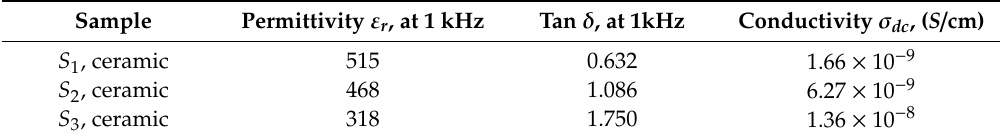
Figure 9. 3D Cole–Cole plots of impedance, measured at room temperature, of the BNT–BT 0.08 / CoFe 2 O 4 sintered ceramics. The symbols represent the experimental data whereas the solid lines are the results of the fitting procedure using the equivalent circuit modeled with the EIS Spectrum Analyzer. Table2. DielectricpropertiesmeasuredatroomtemperaturefortheBNT–BT 0.08 / CoFe 2 O 4 core–shellceramics. Sample Permittivity ε r , at 1